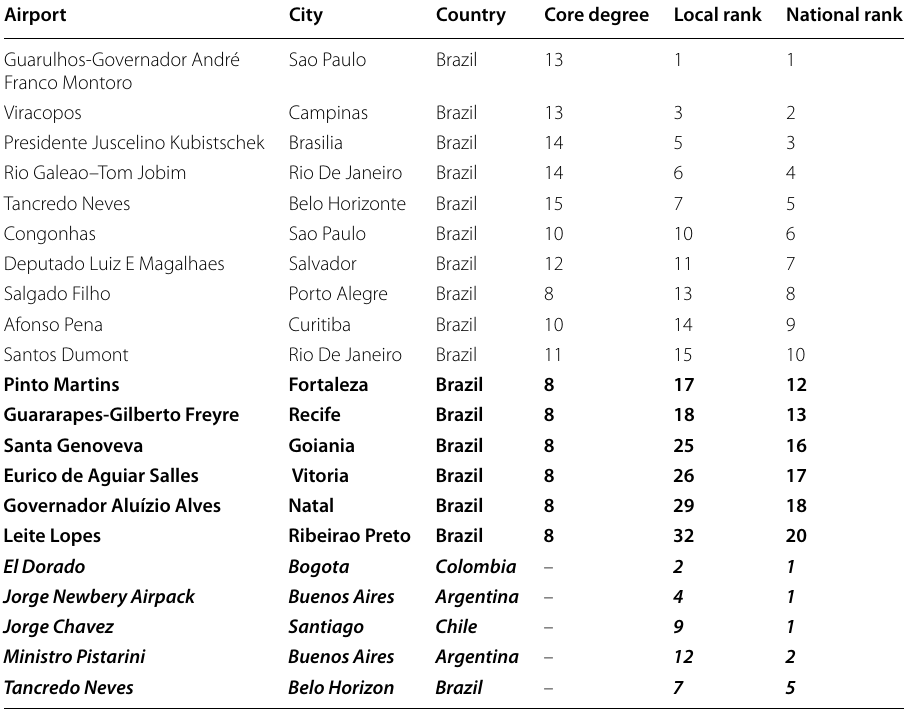
Airports not in the top 16 regional hubs are in bold. The core degree of a node is its number of links in the maximum k-core. Local rank is the rank in the large local component. National rank is the airport rank in its country. Airports in the top 16 regional hubs and not in the k-core are in bolditalic